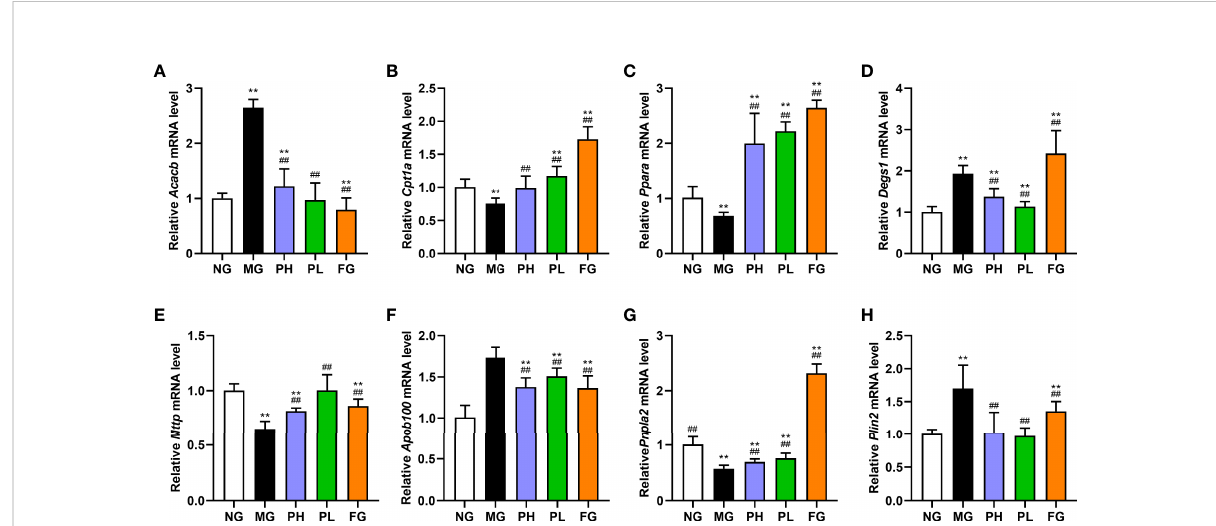
FIGURE 8 Effect of puerarin on expression of lipid metabolism-related genes in liver. (A) Acacb ; (B) Cpt1a ; (C) Ppara ; (D) Degs1 ; (E) Mttp ; (F) Apob100 ; (G) Pnpla2 ; (H) Plin2 . Data were expressed as mean ± SD (n = 10). **p < 0.01, vs. NG; ## p < 0.01, vs.